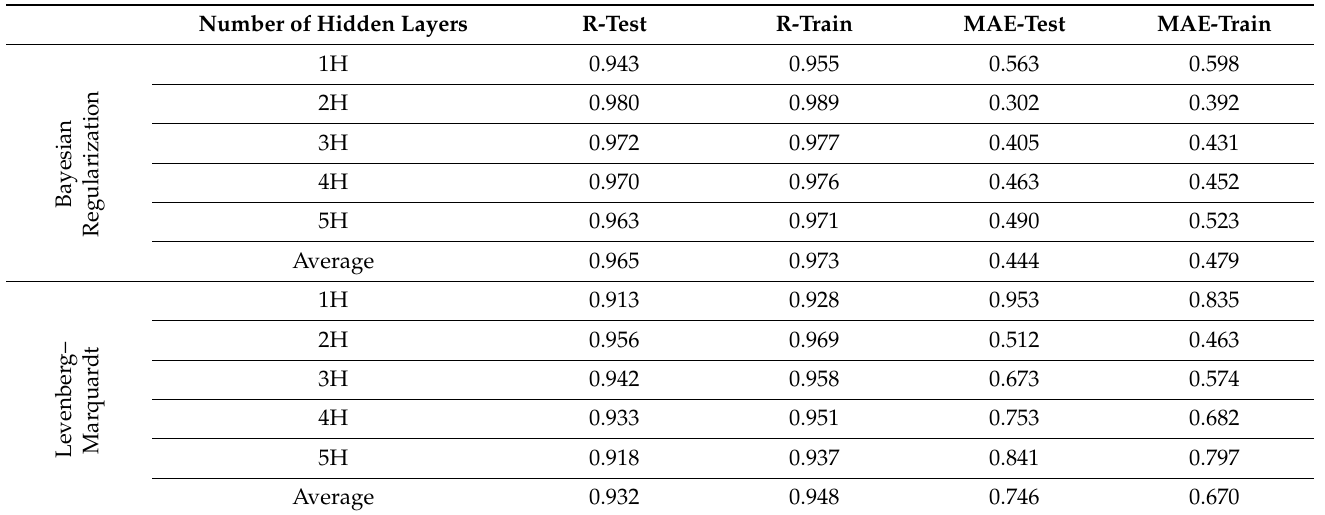
Table 6. The results of ANN